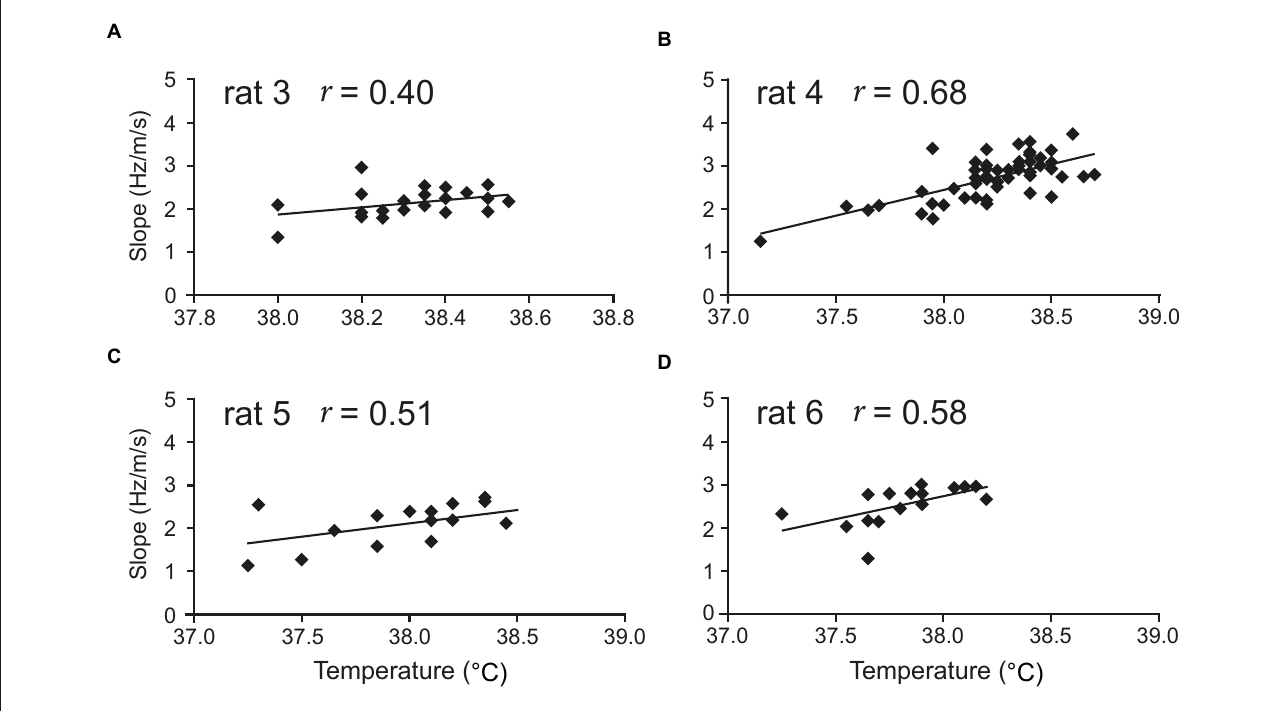
FIGURE3 Aural temperature is positively correlated with theta slope. Temperature measured from the ear of rats in a foraging task (average of pre-trial and post-trial) is positively correlated with the slope component (Hz/m/s) of hippocampal theta frequency. In Wells et al. (2013), seven of eight rats tested from two different labs showed a positive correlation between aural temperature and theta slope [four rats’ data shown here: (A–D) ]. There was no correlation between temperature and theta intercept in any of the eight rats. Figure adapted from Wells et al.